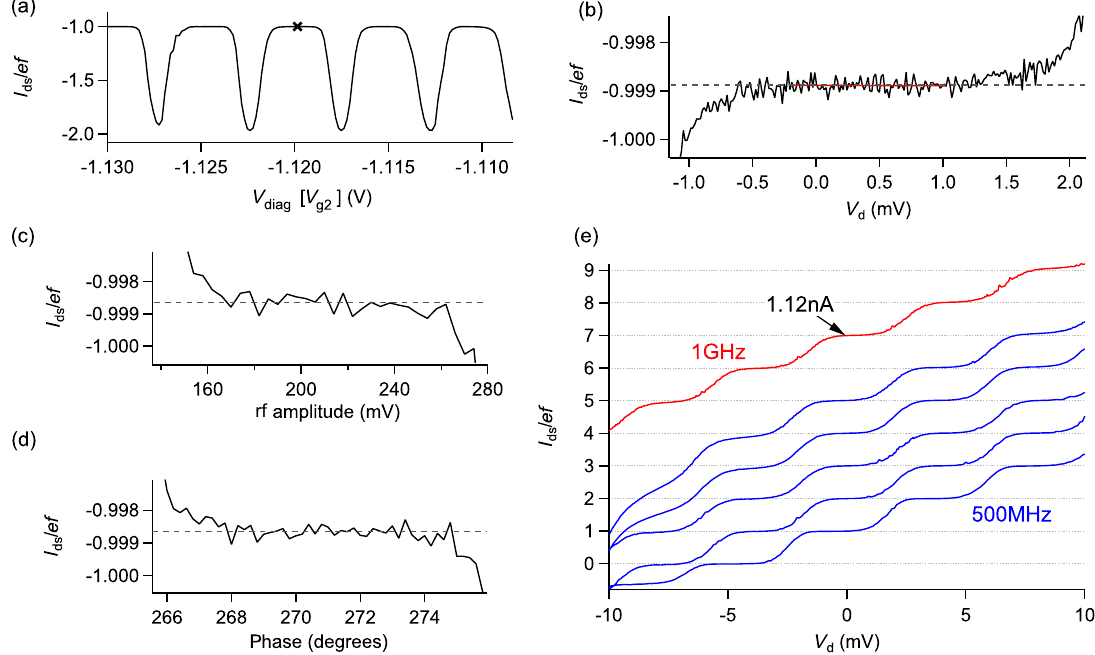
=ef versus V FIG. 4. (a) Pumped current I for sample s 2 and a dephasing of 189 (cid:4) chosen to pump N ¼ (cid:2) 1 electron. The cross ds diag indicates the working point chosen for the measurements shown in (b)–(d), all of which are also performed at 650 MHz and 0.5 K. . The standard deviation of the linear fit across a region wider than 1 mV (in red) sets a lower limit of (b) Pumped current versus bias V d 250 G(cid:1) to the resistance. (c),(d) Pumped current versus rf amplitude on both gates and dephasing, showing a wide range of stability for fixed N ¼ (cid:2) 1 operation. For (b)–(d), a dashed horizontal line is displayed as a guide to the eyes. (e) Same data as (b) but on sample s 3 at 0.6 K, up to 1 GHz, and at higher V . The Coulomb staircase is observed in the pumped current, as an applied V d to the charging energy of the island also forces the population to